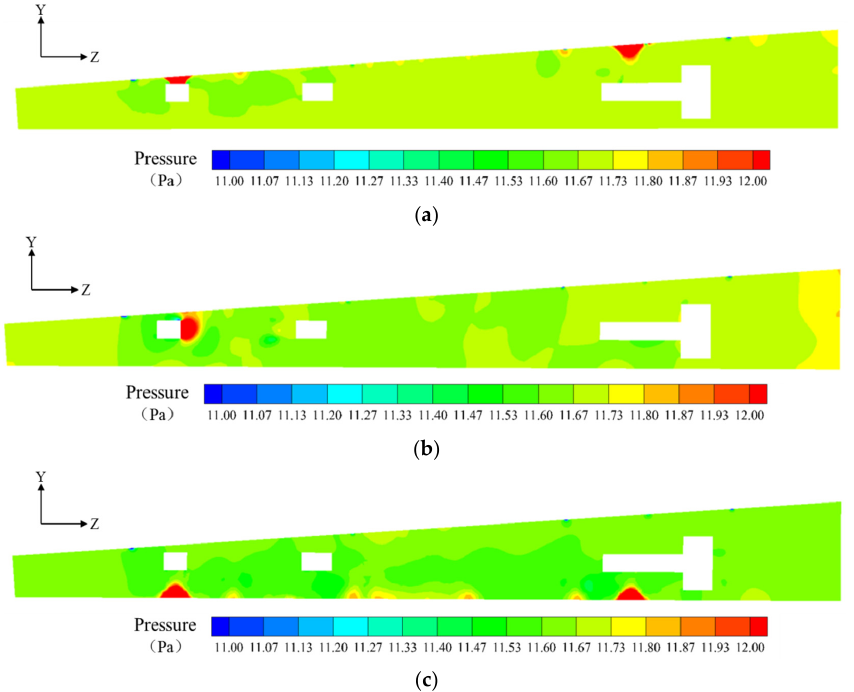
Figure 11. Pressure contours of plenum at section x = 7.62 m. ( a ) case B, ( b ) case C, ( c ) case D.